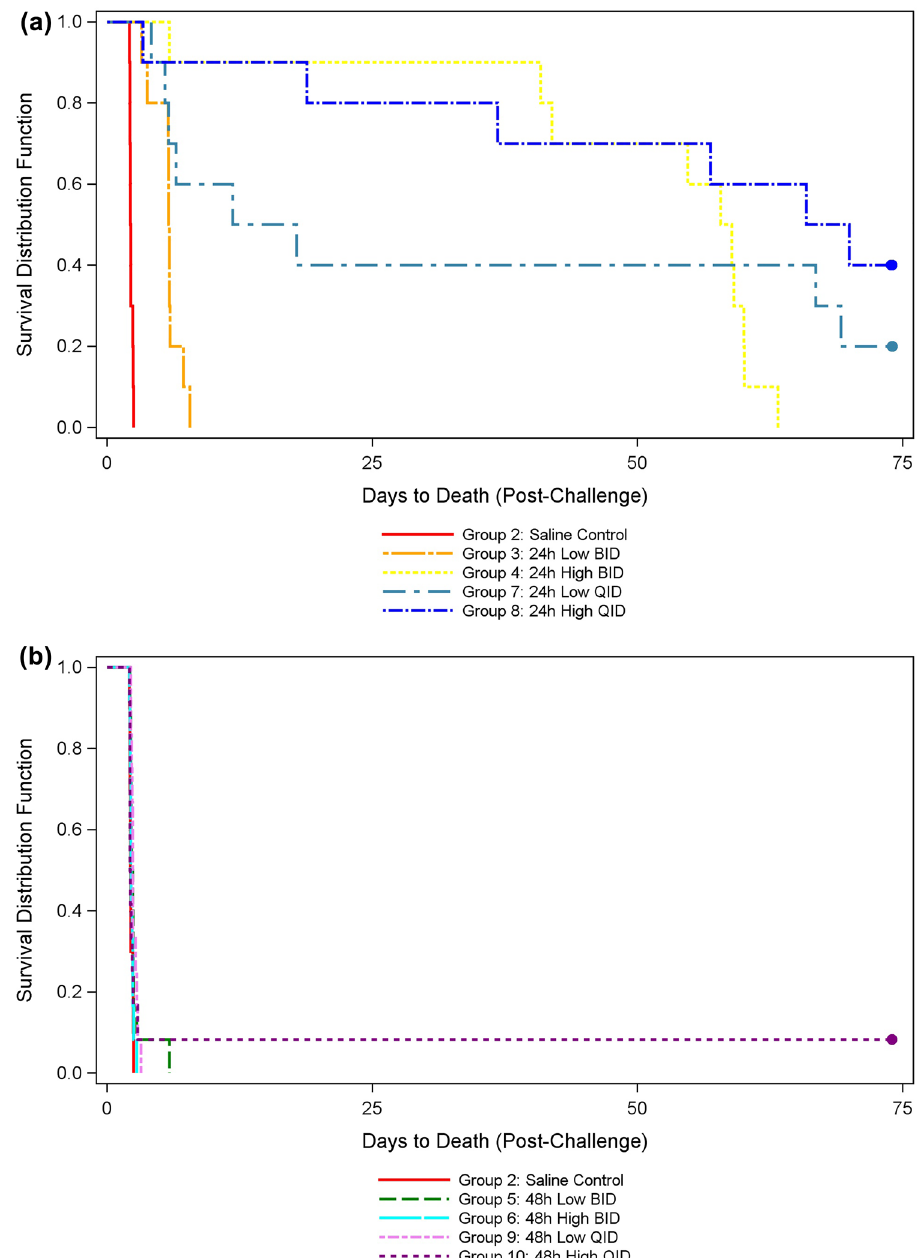
Figure 1. ( a ) Kaplan–Meier survival plot for 24-h intervention groups. Time to death in days for the control group and 24 h post-exposure ceftazidime treated groups (IP administration). Treatments were administered twice daily (BID) or four times daily (QID). BID low dose = 300 mg/kg/treatment, totaling 600 mg/kg/day. BID high dose = 600 mg/kg/treatment, totaling 1200 mg/kg/day. QID low dose = 150 mg/kg/treatment, totaling 600 mg/kg/day. QID high dose = 300 mg/kg/treatment, totaling 1200 mg/kg/day. Survival rates in Groups 4, 7, and 8 at the end of treatment were significantly greater than the control group (p = 0.0002, 0.0383, and 0.002, respectively). Survival rates in Groups 4 and 8 at Study Day 45 (30 days post-cessation of treatment) were significantly greater than the control group (p = 0.0035). Survival rates were not significantly different between the control group and any treated group at Study Day 75. ( b ) Kaplan–Meier Survival Plot for 48-Hour Intervention Groups. Time to death in days for the control group and 48 h post-exposure ceftazidime treated groups (IP administration). Treatments were administered twice daily (BID) or four times daily (QID). BID low dose = 300 mg/kg/treatment, totaling 600 mg/kg/day. BID high dose = 600 mg/kg/treatment, totaling 1200 mg/ kg/day. QID low dose = 150 mg/kg/treatment, totaling 600 mg/kg/day. QID high dose = 300 mg/kg/treatment, totaling 1200 mg/kg/day. At this initiation time point, a single animal survived in the high dose QID group. Time to death in the 48 h post-exposure treatment groups (52.5–58.1 h) was similar to the control group (53.2